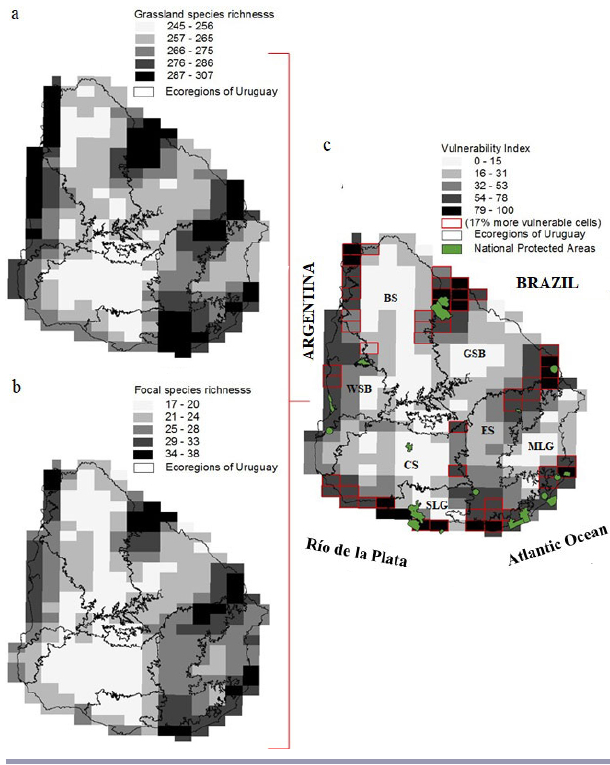
Fig. 2 . Identifying the cells of high diversity of vulnerable species to agricultural expansion in Uruguay. (a) Species richness of woody plants and terrestrial vertebrates of Uruguayan grasslands. (b) Species richness of grassland focal species (i.e., nationally prioritized species). (c) Vulnerability map. The highest (i.e., top 17%) vulnerable cells for each ecoregion and the protected areas of the national system were highlighted. The ecoregions of Uruguay are indicated according to the following codes: Western Sediment Basin (WSB), Basaltic Slope (BS), Crystalline Shield (CS), Gondwanic Sediment Basin (GSB), Merin Lagoon Graben (MLG), Santa Lucía Graben (SLG), and Eastern Sierras (ES).